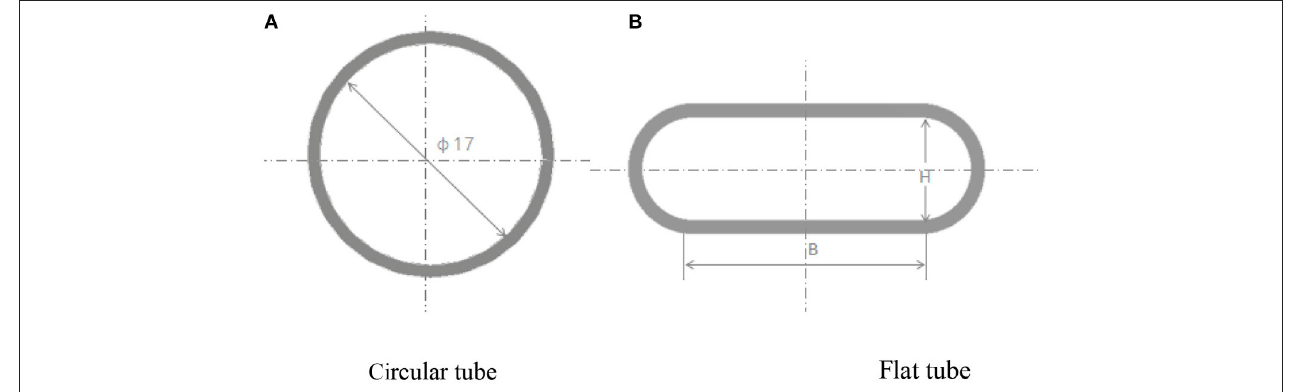
FIGURE 1 | Schematic